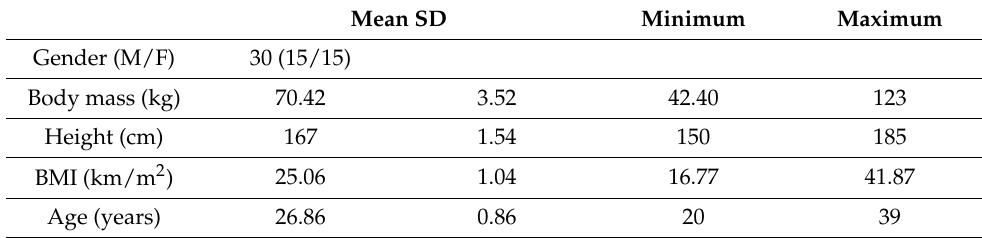
Table 1. Demographic